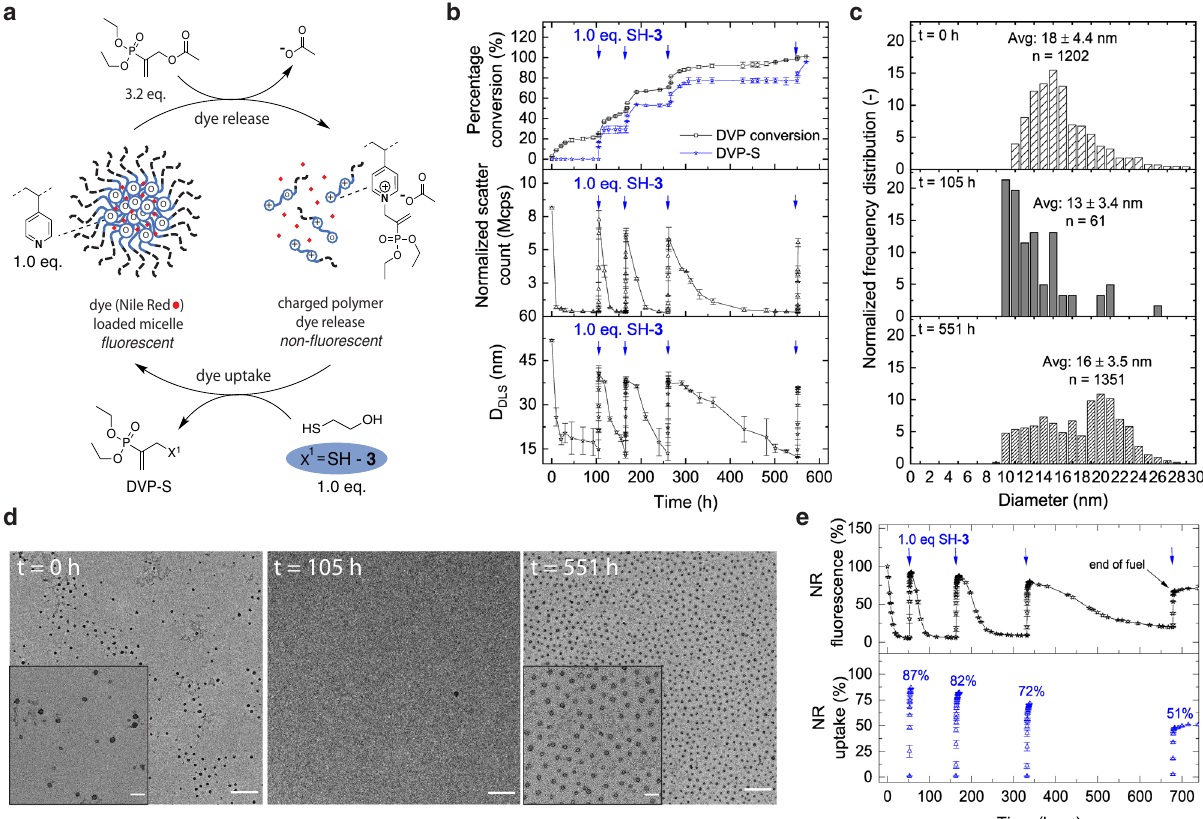
Fig. 3 | Signal-induced micellar (dis)assembly reaction network in the absence and presence ofNileRed (NR).a Micellar dispersions (2.2mg/mL P1) werefuelled with DVP (13mM, 3.2 eq.) and sequential additions of SH- 3 (1.0 eq.) as signal (blue arrow) in 1.0mL phosphate buffer (0.1M, pH=7.4 and 10% D 2 O) (Supplementary Fig. 11). Micellar dispersion in ( e ) contained 15.5±0.1 µ g NR/mg of polymer (encapsulationef fi ciencyof39%),whilemicellardispersionsin( b ),( c )and( d )were withoutNR. b Stackgraph:(top)DVPconversionandDVP-Sformationobservedby 1 H NMR. (middle) Corresponding DLS measured normalized scatter count (Mcps). (bottom) Corresponding DLS measured Z-averaged diameter (D DLS in nm). c NormalizedfrequencydistributionbasedonTEMimageanalysisformicellar(dis) assembly reaction network. At t=0h: initial micelle assembly. At t=105h: